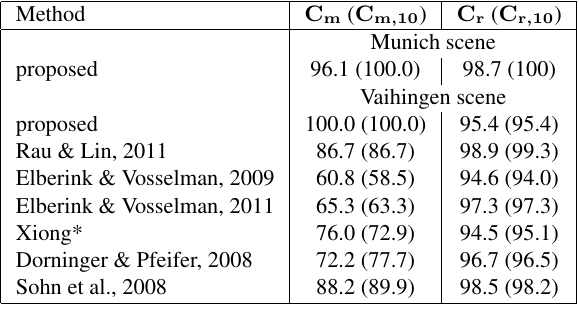
Table 4. Completeness and correctness of the reconstruction. Re- sults of the Vaihingen Scene are compared to the results of other methods (* see Rottensteiner et al., 2012).